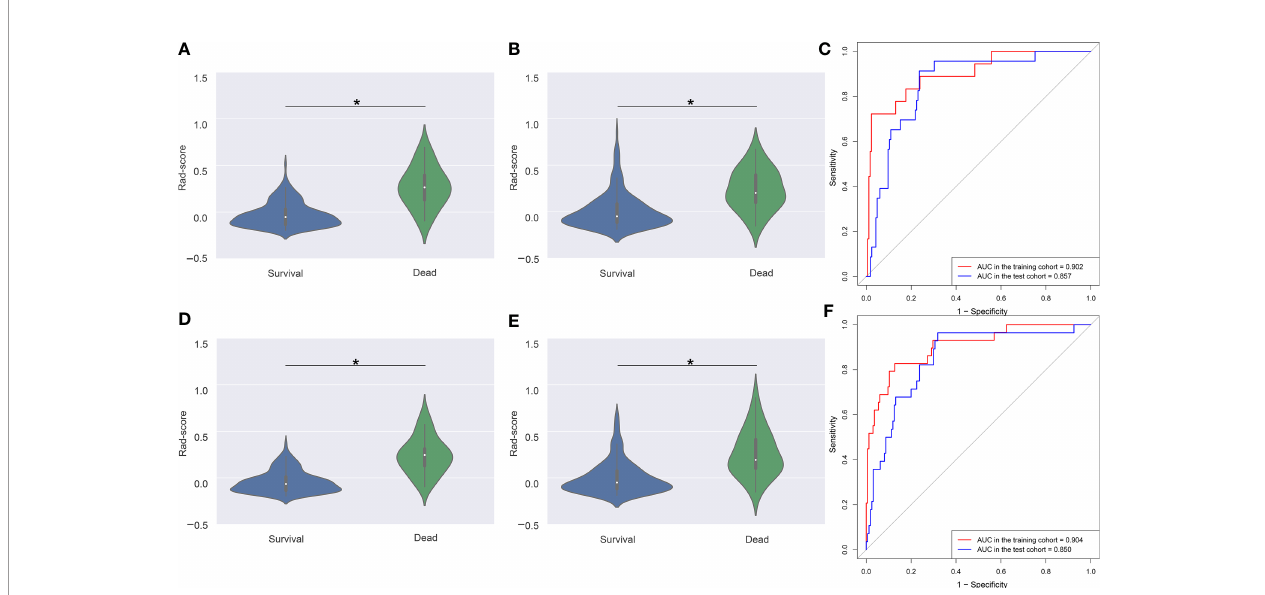
FIGURE 4 | Violin plots and ROC curves of Rad-score in 3- and 5-year survival and dead groups. Violin plots show the distribution of Rad-score in 3-year survival and dead groups in the training (A) and test (B) cohorts. The median (central white dot), interquartile range (black box), and 95% con fi dence interval (vertical line) are shown in the middle. The color area represents a density plot on the side. ROC curves (C) for 3-year survival were determined to assess prognostic accuracy in the two cohorts. Violin plots (D, E) and ROC curves (F) in 5-year survival and dead groups. ROC, receiver operator characteristic. AUC, area under the curve. *P <